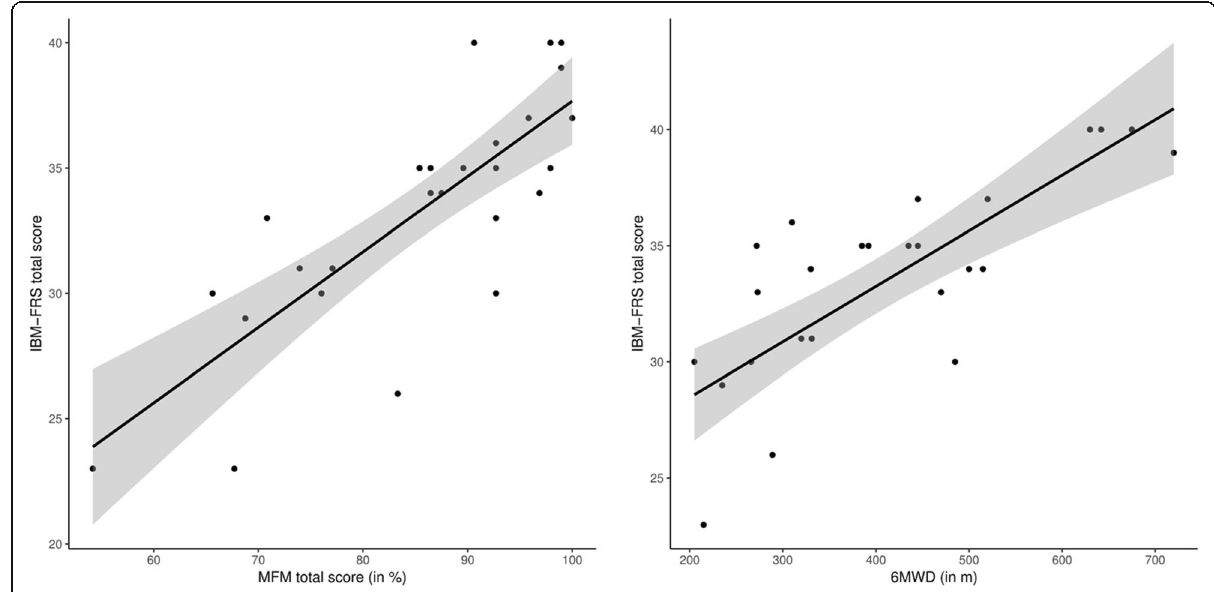
Fig. 3 The relationship between the IBM-FRS and the clinical outcomes at baseline. The grey surface represents the 95%